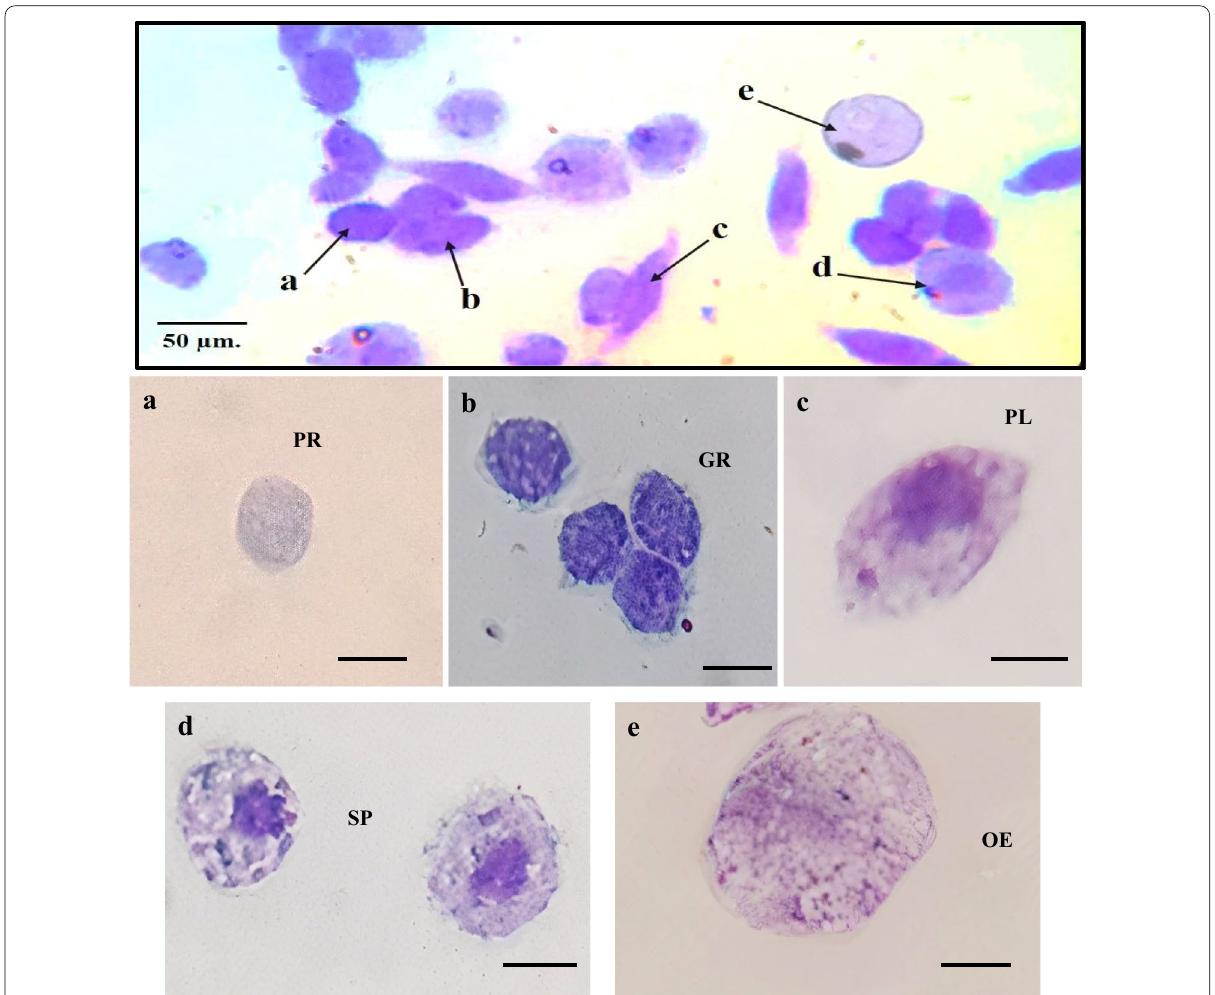
Fig. 3 Five hemocytes types in G. mellonella larval hemolymph: a Prohemocytes (PR), b Granulocytes (GR), c Plasmatocytes (PL), d Spherulocytes (SP), e Oenocytoids (OE). Photographs were made using a 1,000